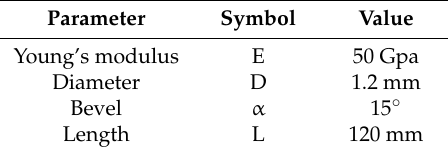
Figure 2. Flexible needles with a bevel tip. Table 1. Parameters of the flexible needle.